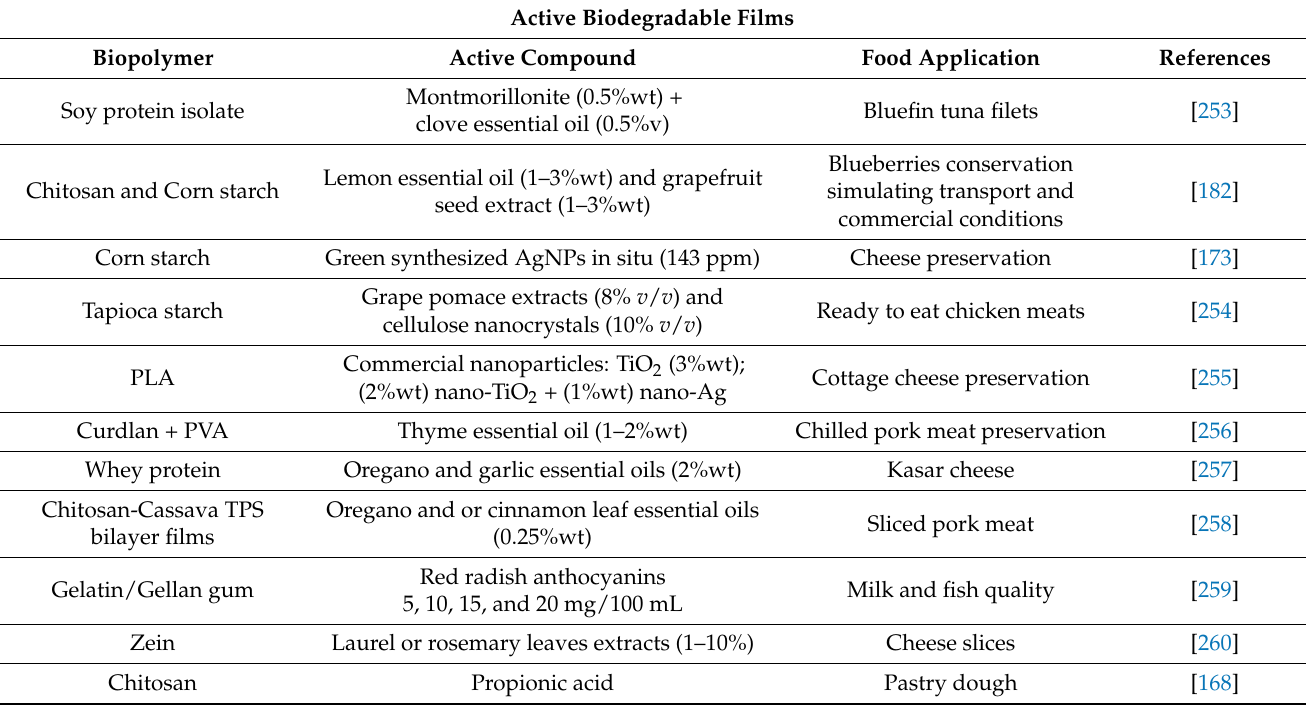
Table 2. Active and intelligent biodegradable films and their food